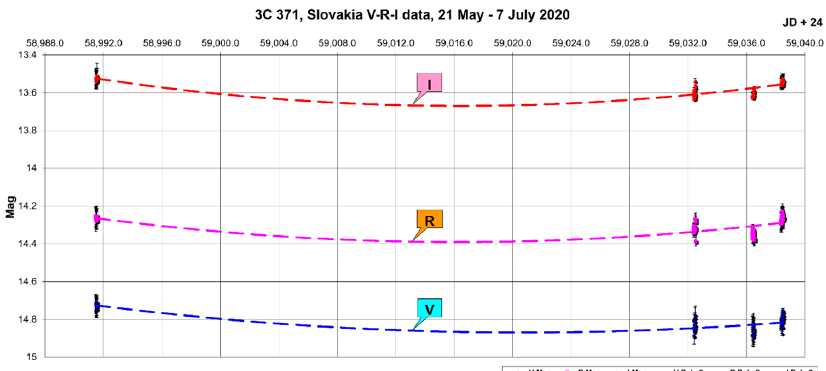
Figure 14. Light curve of 3C 371 observations, obtained at the Vihorlat observatory in filters V, R, I. Dotted trend lines-polynomials of 2 degree.